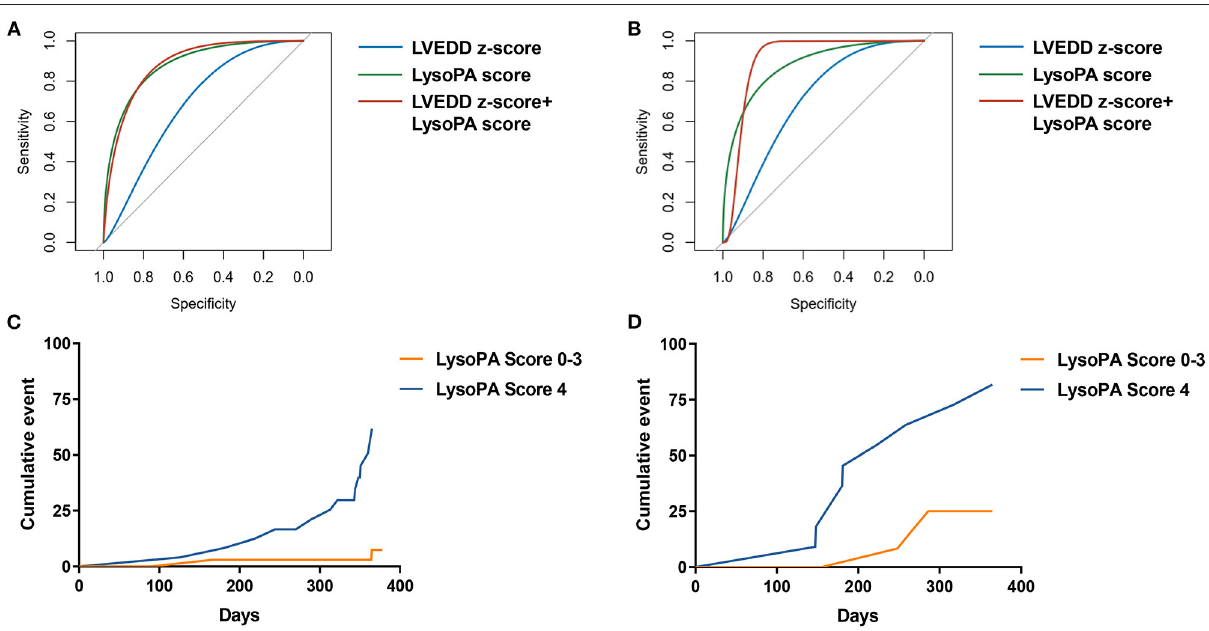
Frontiers in Pediatrics |